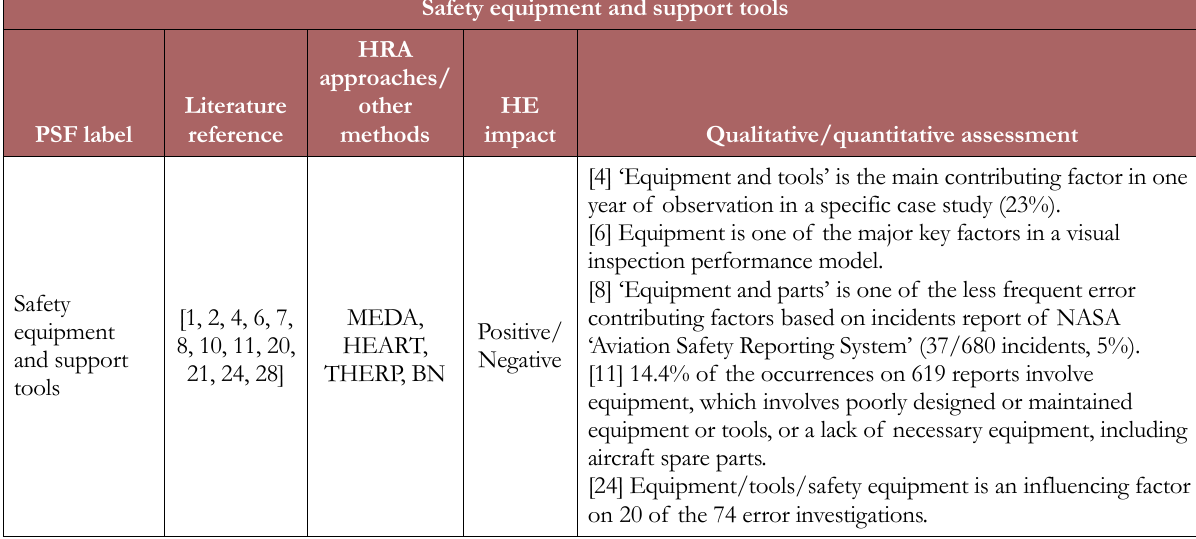
Table 9. Taxonomy of maintenance PSFs: safety equipment and support tools factor Other PSFs, such as ‘available time’ (Table 10) and ‘complexity’ (Table 11), are present in the literature, but with a lower frequency, given the least impact on maintainers’